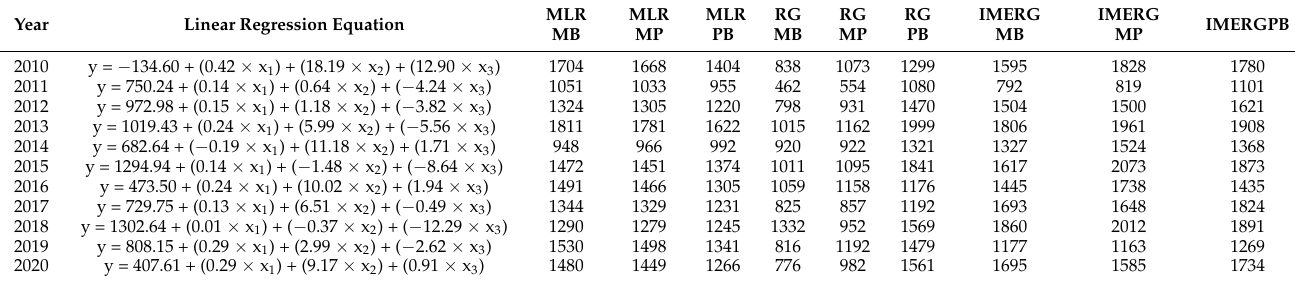
Table 5. Cumulative annual precipitation for Monte Bove Sud (MB), Monte Prata (MP) and Pintura di Bolognola (PB), calculated through interpolation (MLR), IMERG data to which was added the real snowfall data (IMERG) and the data measured by the rain gauge (RG); x 1 = altitude, x 2 = distance from the sea, x 3 = distance from the main ridge. Year Linear Regression Equation MLR MB